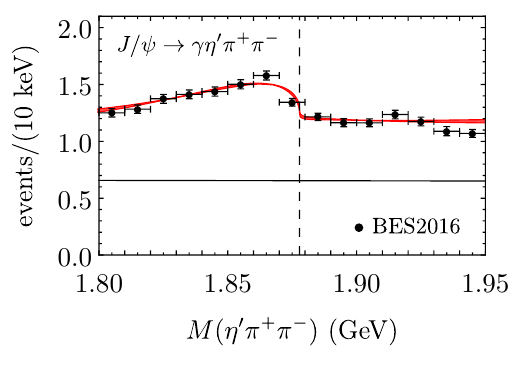
Figure 6. The η (cid:48) π + π − invariant mass spectrum in the decay J /ψ → γη (cid:48) π + π − . The thin line shows the contribution of non- N ¯ N channels. Vertical dashed line is the N ¯ N